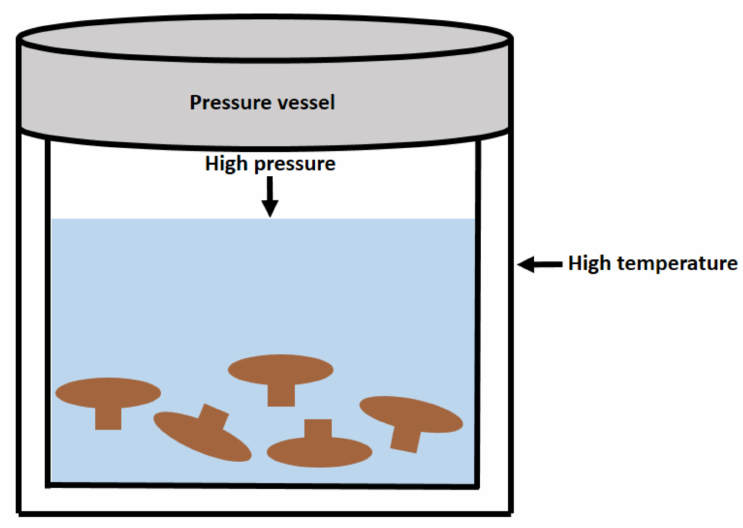
Figure 4. EFP extraction by SWE.